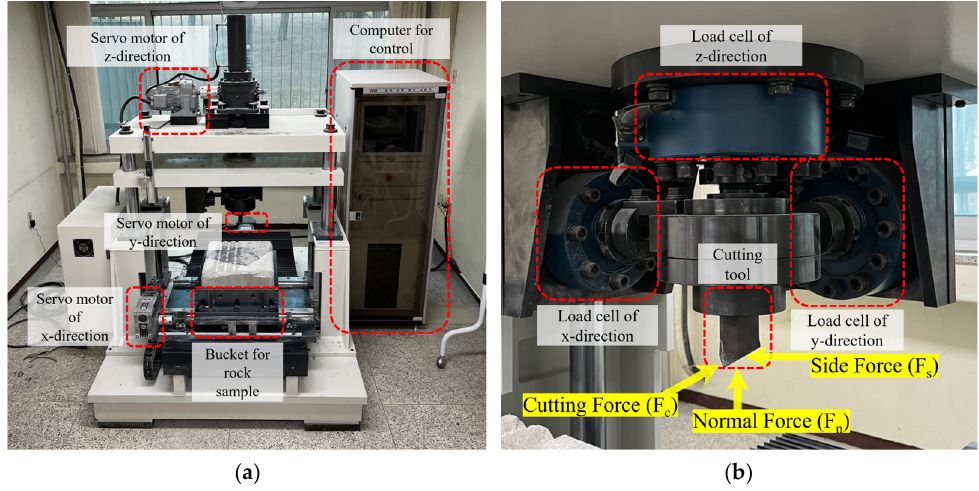
Figure 2. Linear cutting machine (LCM): ( a ) overview of LCM; ( b ) load cells and cutting tool.